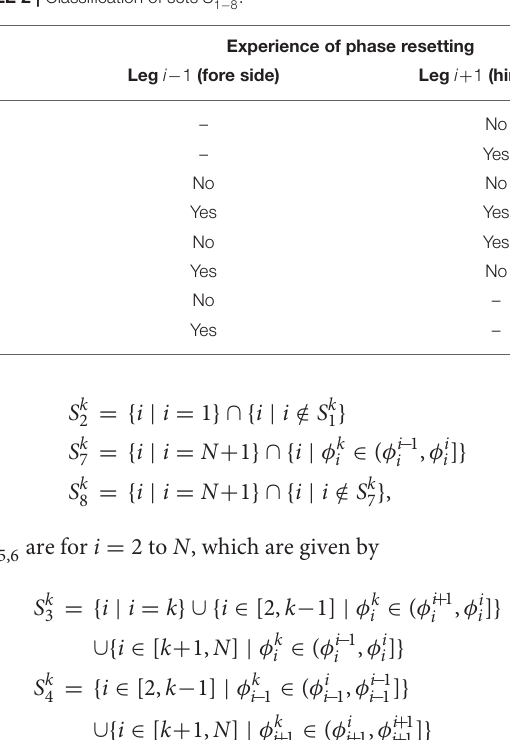
TABLE 2 | Classification of sets S k 1